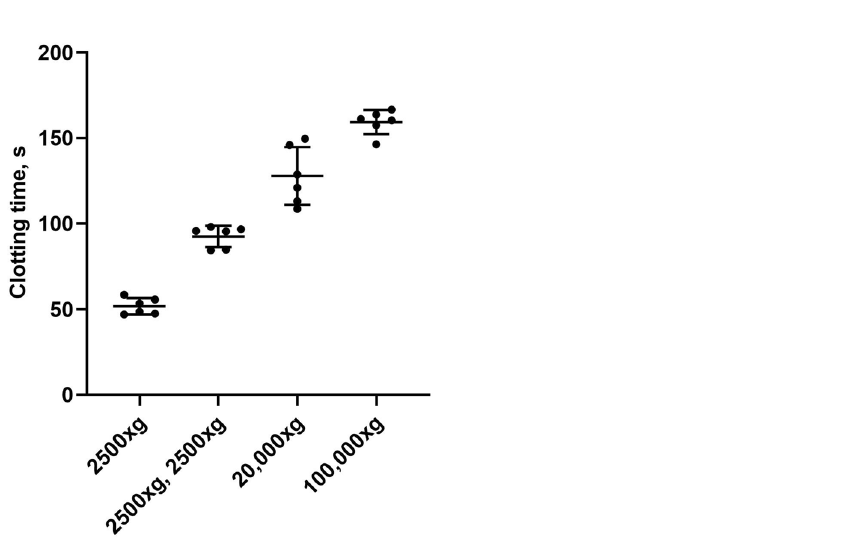
Figure 1. The effect of sequential centrifugation on plasma PPL clotting times. Citrated blood collected from 6 healthy volunteers was subjected to consecutive centrifugations: 2500× g for 15 min to obtain platelet poor plasma (PPP), 2500× g for 15 min to obtain platelet free plasma (PFP), 20,000× g for 30 min and 100,000× g for 1 h to deplete for EVs. A sample of plasma after each centrifugation was analyzed with the modified PPL assay. The PPL activity is presented in seconds (s) of clotting time. Dot plot with mean ± 1 SD (n = 6 for each